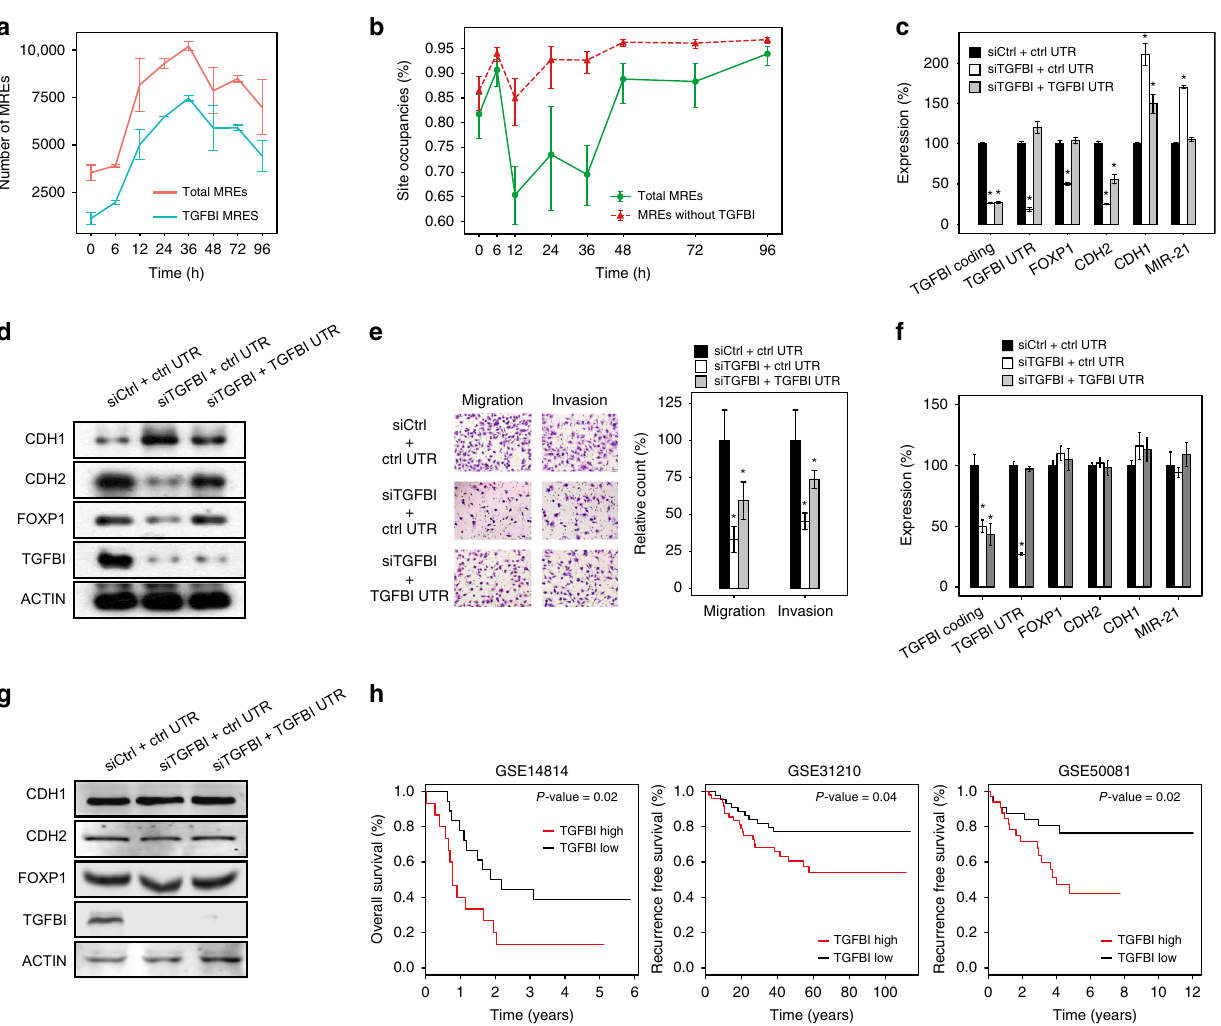
Fig. 3 TGFBI is a functional ceRNA for miR-21 to regulate EMT. a Graph showing the number of miR-21 MREs extrapolated from RNA-seq data during TGF- β -induced EMT in A549 cells using targetScan-based predictions. b Graph showing the dynamics of modeled 8-mer miR-21 binding site occupancy during TGF- β -induced EMT in A549 cells using targetScan-based predictions. c Graph showing the level of indicated RNAs in A549 cells during TGF- β -induced EMT subjected to the indicated treatments. d Same as ( c ) for the immunoblotting analysis. e A549 cells undergoing TGF- β -induced EMT were treated as indicated and subjected to a migration assay (left panel) and an invasion assay (right panel). Scale bars: 100 μ m. The migrated or invaded cells were quanti fi ed (bar charts). n = 6. f Graph showing the level of indicated RNAs in A549 cells during TGF- β -induced EMT subjected to the indicated treatments, using cells whose DICER1 has been knocked out with CRISPR-Cas9. g Same as ( f ) for the immunoblotting analysis. h Kaplan – Meier survival analyses based on the overexpression of TGFBI in three independent lung cancer data sets. n = 3; error bars indicate the means ± s.d. * p < 0.01, determined using a two- tailed Student ’ s t test. Source data are provided as a Source Data fi